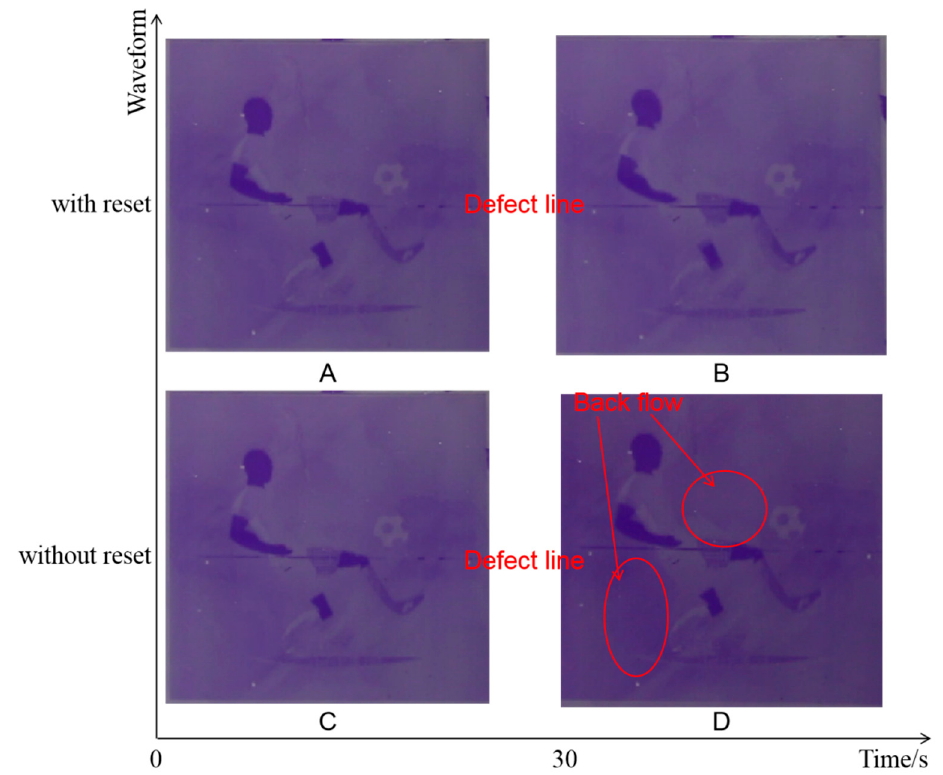
Figure 9. Comparison of static images with different driving waveforms. The ordinate indicates the driving waveform used in the experiment, and the abscissa indicates time. At 0 s, image ( A ) was recorded with the reset waveform and image ( C ) was recorded without the reset waveform. After 30 s, image ( B ) was recorded with the reset waveform and image ( D ) was recorded without the reset waveform. There is an uncontrollable line in the middle of the screen, which is a defect in the gate chip binding.